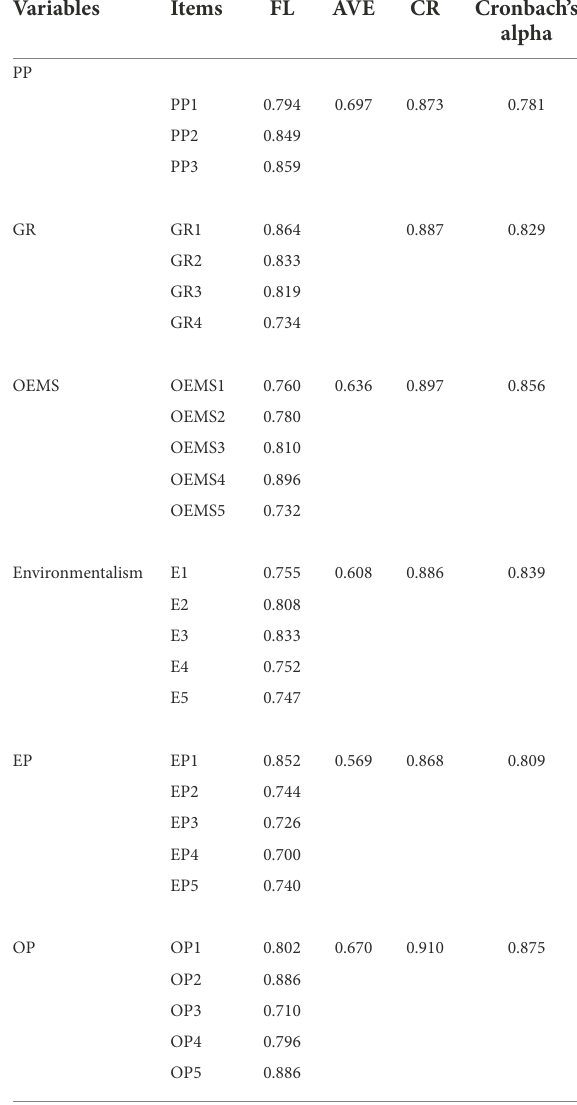
TABLE 2 Evaluation of the measurement model.